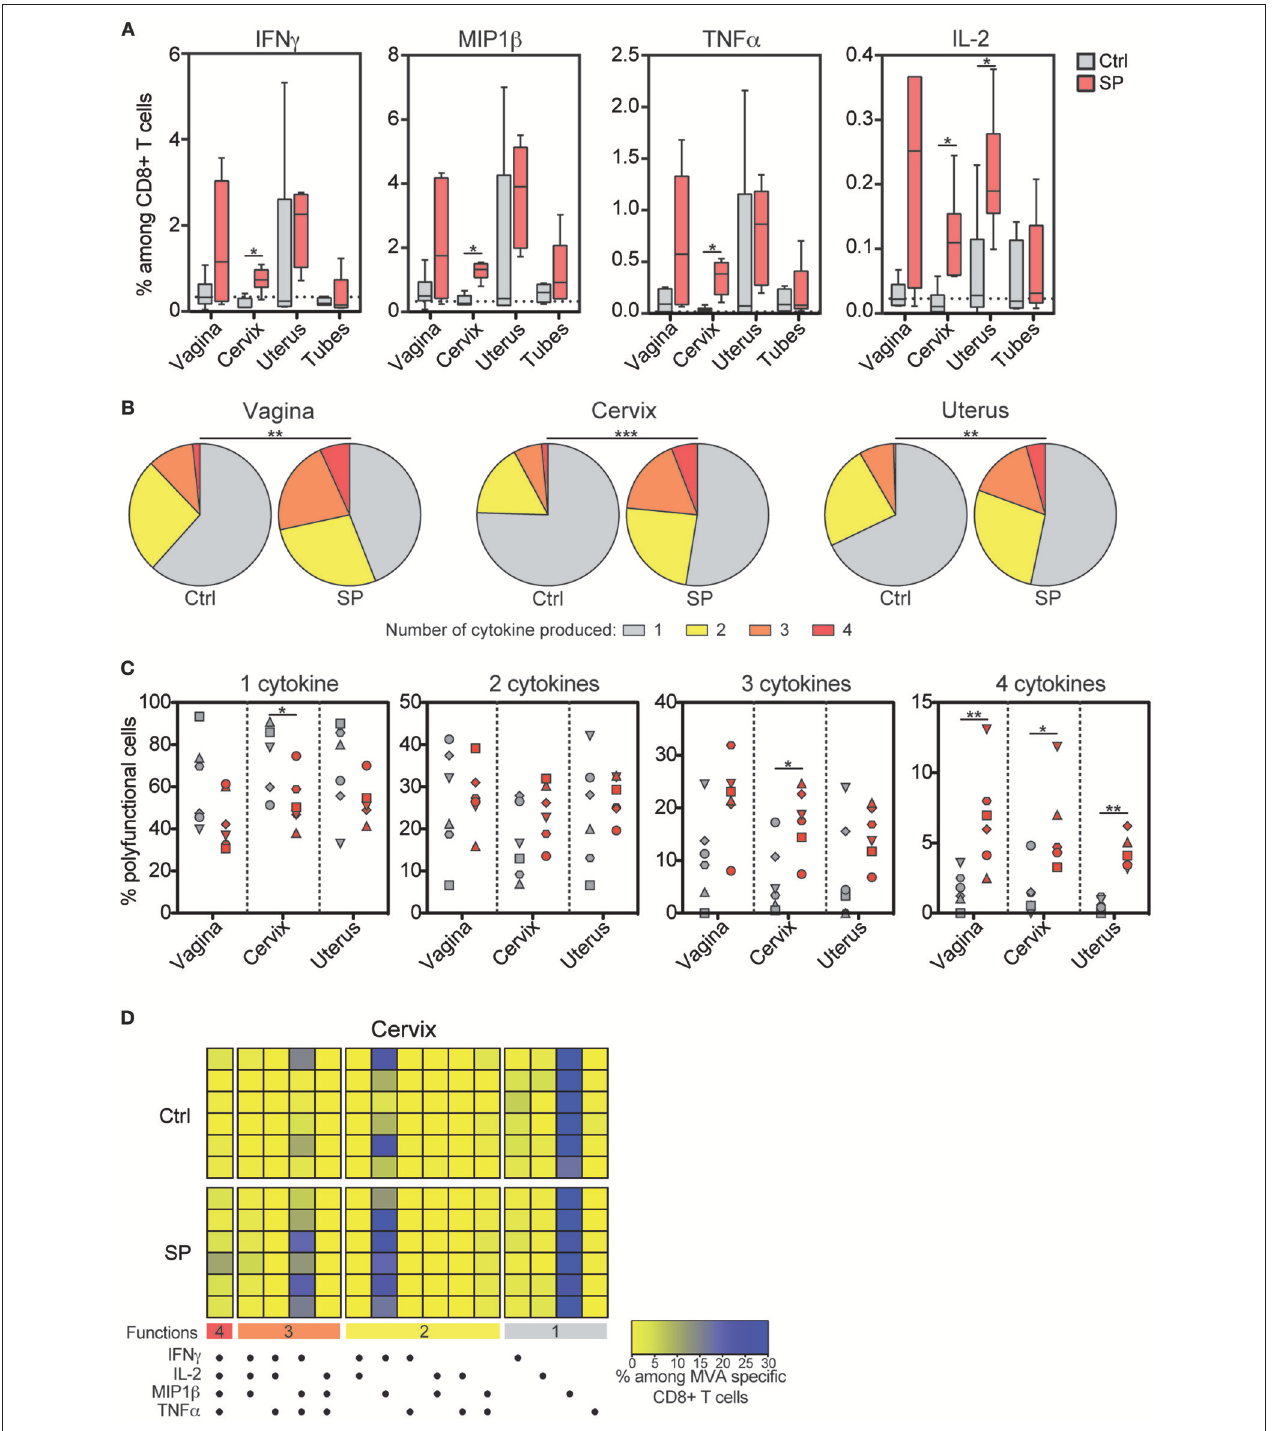
FIGURE 2 | Frequency and quality of vaccine-specific mucosal CD8 + T cell responses increase after SP exposures. (A) Percentage of IFN- γ + , MIP-1 β + , TNF- α + , and IL-2 + cells among MVA specific CD8 + T cells in FRT tissues after in vitro stimulation. Control animals (Ctrl) are indicated in gray and SP exposed animals (SP) in red. The horizontal dotted line indicates the mean background signal measured in unstimulated cells. (B) Pie chart graphs indicating the number of cytokines produced by the MVA-specific CD8 + T cells in the mucosal compartments. The means of the six animals of each group are represented in the pie charts. (C) Number of cytokines produced among the MVA specific CD8 + T cells in control (gray) and SP exposed (red) animals. Each symbol represents an animal. (D) Polyfunctional CD8 + T-cell profiles analyzed by Boolean gating in cervical tissue are represented as a heat map. Each colored horizontal line indicates one animal [ n = 6 for the control group (Ctrl) and n = 6 for the SP exposed group (SP)]. The Mann-Whitney (*) was used to compare animal groups (* p < 0.05) and the Chi-squared test to compare the pie charts (** p < 0.005 and *** p < 0.001).